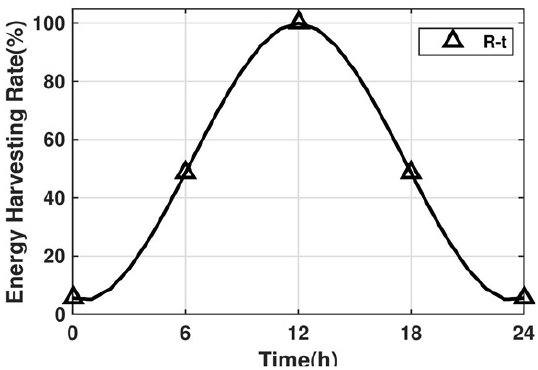
Figure 3. Energy harvesting rate in different time instant